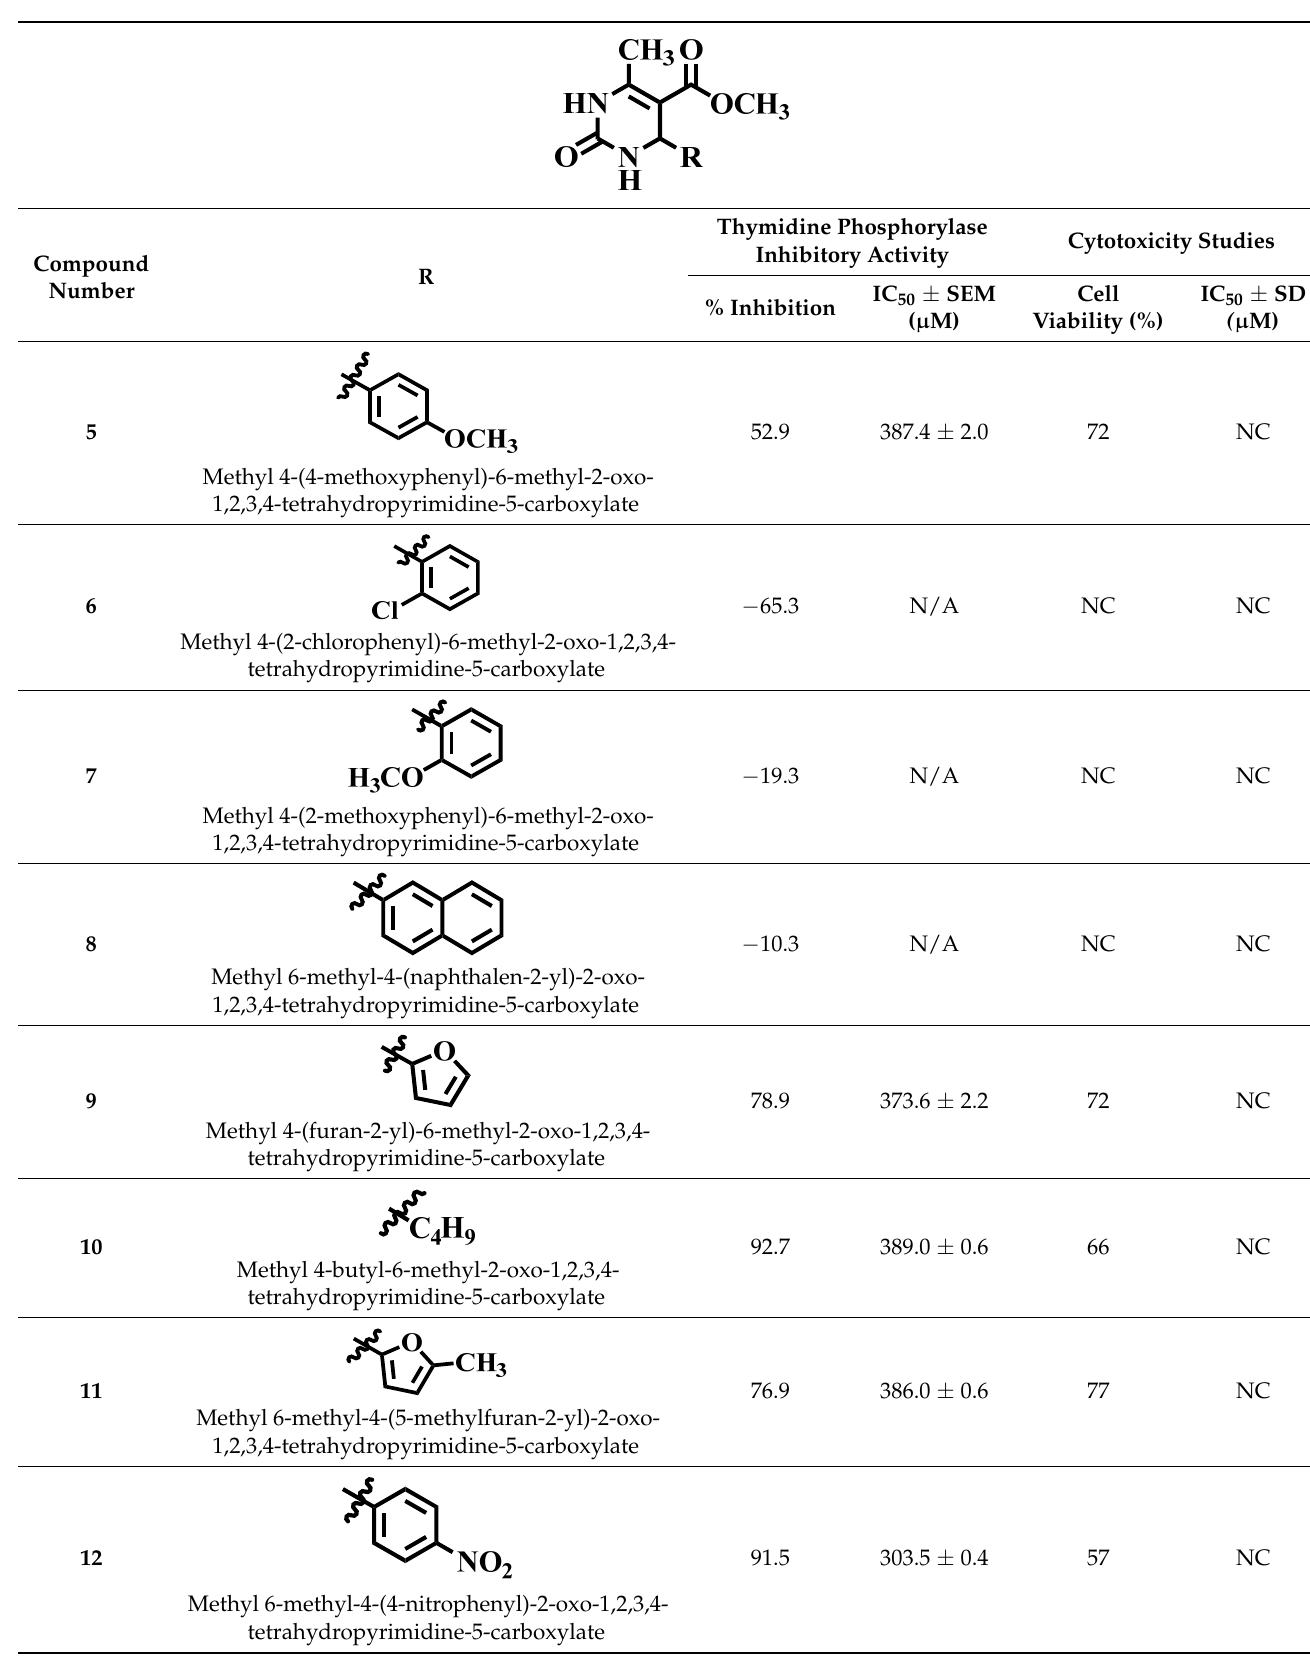
Table 1. Thymidine phosphorylase (TP) inhibitory activity of dihydropyrimidone ( 1 – 40 Table 1. Cont.